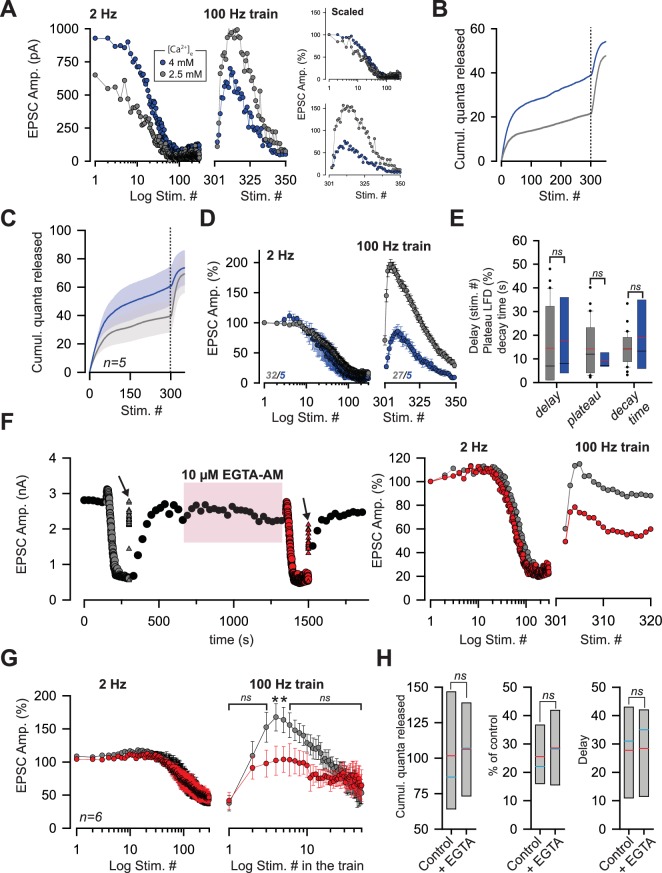
The reluctant pool can be recruited by increasing pr.(A) Amplitude of ESPCs in the same PC during LFD (left panel) and during the recovery from LFD (middle panel) by a 100 Hz train before and after an increase in [Ca2+]e from 2.5 mM (gray points) to 4 mM (blue point). The right panels show the same experiment with EPSC amplitudes normalized with respect to the first response of LFD (B) Corresponding cumulative number of quanta release during LFD (stimuli #1 to #300) and during the recovery train (stimuli #301 to #350) in low and high [Ca2+]e. (same color code than in A). (C), Mean values of the cumulative number of quanta release during LFD (stimuli #1 to #300) and during recovery train at 100 Hz (stimuli #301 to #350) in low and high [Ca2+]e. The dashed line represents the end of the LFD protocol (same color code than in A). LFD and recovery trains were recorded in the same PCs. (D), Mean values of normalized EPSC amplitudes during LFD (left panel) and during the recovery via a 100 Hz train (right panel) in presence of 2.5 mM (gray points, same set of data than in Figure 1E for LFD and same set of data than in Figure 2D for recovery trains) and 4 mM [Ca2+]e (blue points). EPSC amplitudes were normalized with respect to the first response of LFD. (E) Box-plots showing the delay (mean number of stimuli before the onset of LFD: 14.5 ± 2.8, n = 30 at [Ca2+]e = 2.5 mM compared to 17.6 ± 8.0, n = 5, at [Ca2+]e=4 mM, MWRST, p=0.60), plateau of LFD (mean percentage of initial responses: 14.2 ± 2.0%, n = 30 at [Ca2+]e = 2.5 mM compared to 9.3 ± 1.4%, n = 5, at [Ca2+]e=4 mM, p=0.69, MWRST) and decay time (tau: 14.3 s ± 1.3 s, n = 30 at [Ca2+]e = 2.5 mM compared to 18.9 s ± 6.8 s, n = 5, at [Ca2+]e=4 mM, p=0.87, MWRST) in presence of 2.5 mM (gray boxes, same set of data than in Figure 1E for LFD and same set of data than in Figure 2D for recovery trains) and 4 mM [Ca2+]e (blue boxes). Black and red lines indicate median and mean values, respectively. (F) left, typical experiment showing the time course of EPSC amplitudes before and after application of 10 µM EGTA-AM. Black points correspond to EPSCs recorded during 0.033 Hz stimulation. Gray and red symbols correspond to EPSCs recorded during LFD (circles) and during the recovery trains at 100 Hz (triangles) before and after the bath application of 10 µM EGTA-AM respectively. Arrows indicate the application of a recovery train at 100 Hz. The pink box represents the bath application of 10 µM EGTA-AM. Right, corresponding ESPC amplitudes normalized with respect to the first response of LFD. (G) Mean EPSC amplitudes recorded during LFD (left panel) and during recovery trains (right panel) before (gray points) and after (red points) application of EGTA-AM. Note the difference in EPSC amplitudes evoked during the first stimuli at 100 Hz. Numbers at the bottom of the graphs indicate the number of cells recorded. (H) Box-plots showing the cumulative number of quanta released during LFD, the plateau of LFD and the delay before the onset of LFD before and after application of 10 µM EGTA-AM (same set of experiment as in G). None of these three parameters were statistically different between the two conditions (paired t-test, p=0.65, for the cumulative number of quanta released, paired t-test, p=0.39 for the plateau of LFD and paired t-test, p=0.89, for the delay, n = 6). Blue and red lines indicate median and mean values respectively.